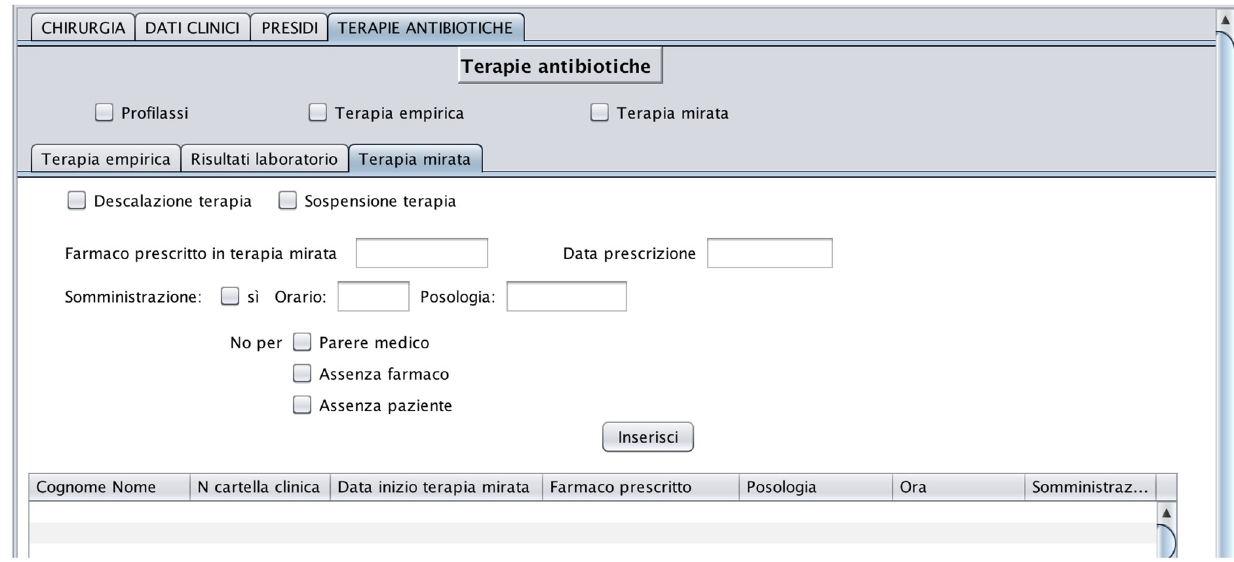
Fig 14. Therapy panel (Terapie antibiotiche) and target therapy sub-panel (Terapia mirata).